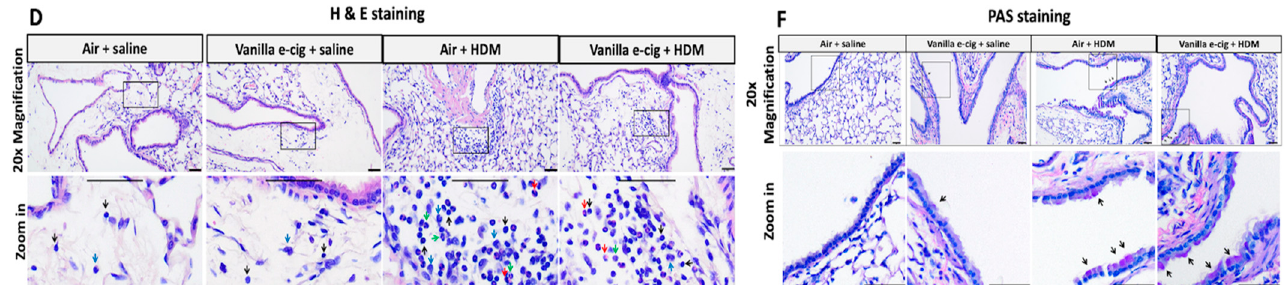
Figure 5. Prenatal exposures to vanilla-flavored e-cig aerosol + HDM treatment exacerbates lung mucous metaplasia. ( A – C ) Histopathological assessment of the lung tissue for peribronchial, alveoli and perivascular inflammation. ( D ) Representative H&E-stained lung slide for each group. All scale bars are 50 µm. Images show low numbers of perivascular and peribronchial leukocytes in the Air + saline and Vanilla e-cig + saline groups. Leukocyte numbers are increased in the Air + HDM and Vanilla e-cig + HDM groups. Blue arrows indicate macrophages; black arrows indicate lymphocytes; red arrows indicate eosinophils; and green arrows indicate neutrophils. ( E ) Histopathological assessment of lung mucous metaplasia. ( F ) Representative PAS-stained lung slides. All scale bars are 50 µm. No PAS-positive cells (purple stained cytoplasm) are observed in the control group (Air + saline), and rare scattered PAS-positive cells (arrows) are noticed in the vanilla e-cig + saline group. Minimal and mild increases of PAS-positive cells (arrows) are noticed in Air + HDM and Vanilla e-cig + HDM groups, respectively. Data are expressed as median ± interquartile range. The interquartile range shows the distribution of the data between the 25th and the 75th percentile. N = 4–5 male mice per group. The Kruskal–Wallis test was used to determine statistical differences. * p < 0.05.